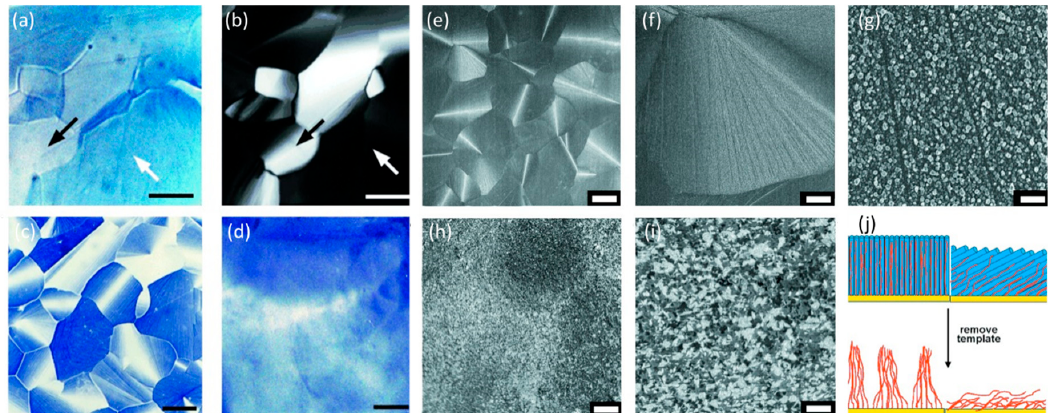
Figure 5. ( a – d ) Polarising optical microscopy images of the poly (3,4-ethyldioxythiophene) (PEDOT) electropolymerised on indium tin oxide. ( a ) Nonpolarised and ( b ) between crossed-polarisers images of PEDOT in the liquid crystal template during polymerisation. Black arrows show a domain with the liquid crystal director parallel to the substrate and white arrows indicate domains with a director normal to substrate. ( c ) Domain structure of a similarly grown PEDOT film after the liquid crystal (LC) template is removed. ( d ) PEDOT polymerised in isotropic solution. Length of scale bars is 100 µm. ( e ) SEM image of the PEDOT film after the removal of the LC template. Templated polymer films have textures similar to focal conic textures of liquid crystals. The length of the scale bar in ( e ) 50 mm, ( f ) 10 mm and ( g ) 1 mm. ( h , i ) Non-templated film grown from isotropic solution. ( h ) bar = 50 mm, ( i ) bar = 5 mm. ( j ) Schematic diagram depicting the directed aggregation of oriented conducting polymer chains. Reprinted with permission from Hulvat et al., Angew. Chem. Int. Ed. 2003 , 42 , 7, 778–781.